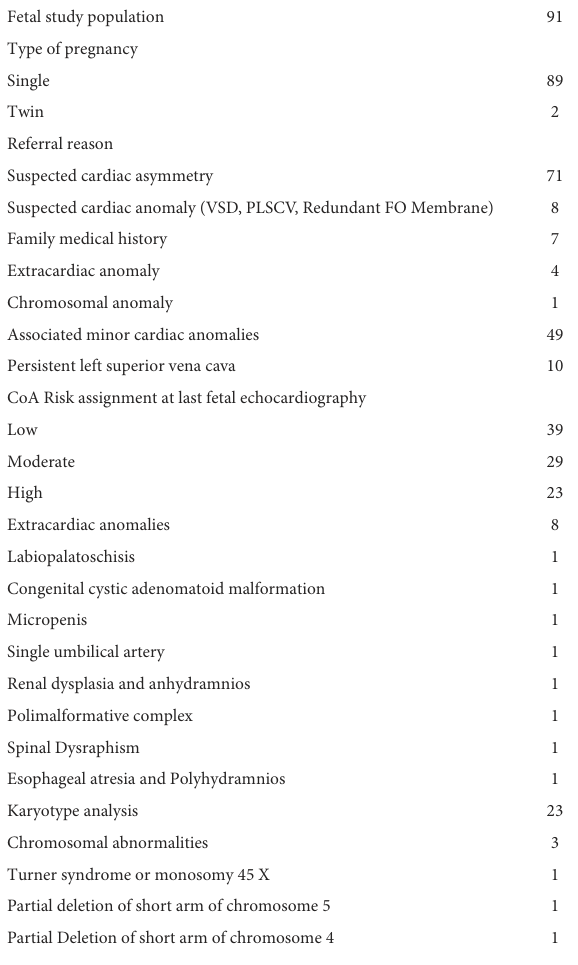
TABLE 1 Prenatal details of the study population (fetuses with suspected coarctation of the aorta, CoA).